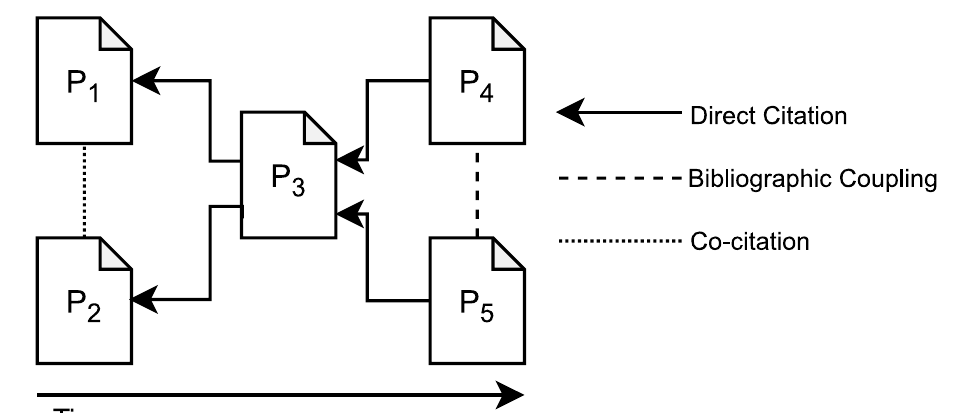
Figure 1. Bibliographic coupling and co-citation analyses.